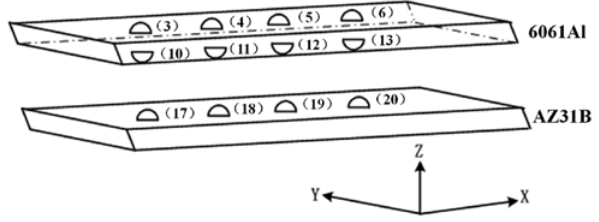
Figure 8: Schematic for points selected on the aluminum and magnesium alloy